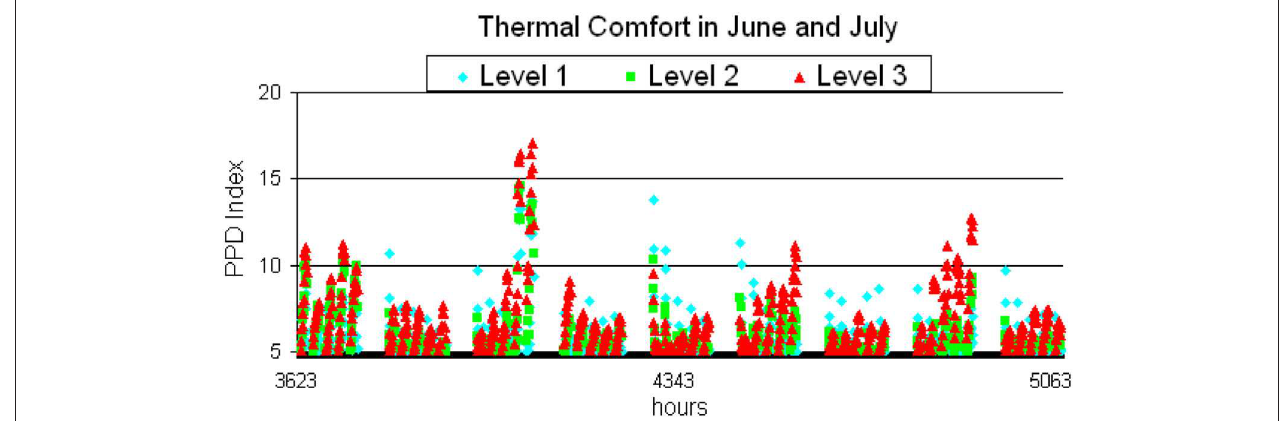
FIGURE 9 | Average PPD at different orientations during June and July using Hybrid 3 (assuming 2 clothing level = 0.7 clo; activity = 1.2 met; air velocity = 1.2